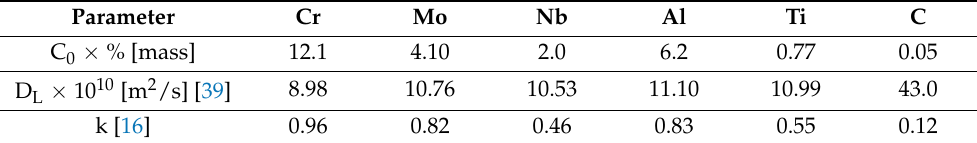
Table 1. Parameters used in the micro-segregation model for different alloying elements of IN713LC.